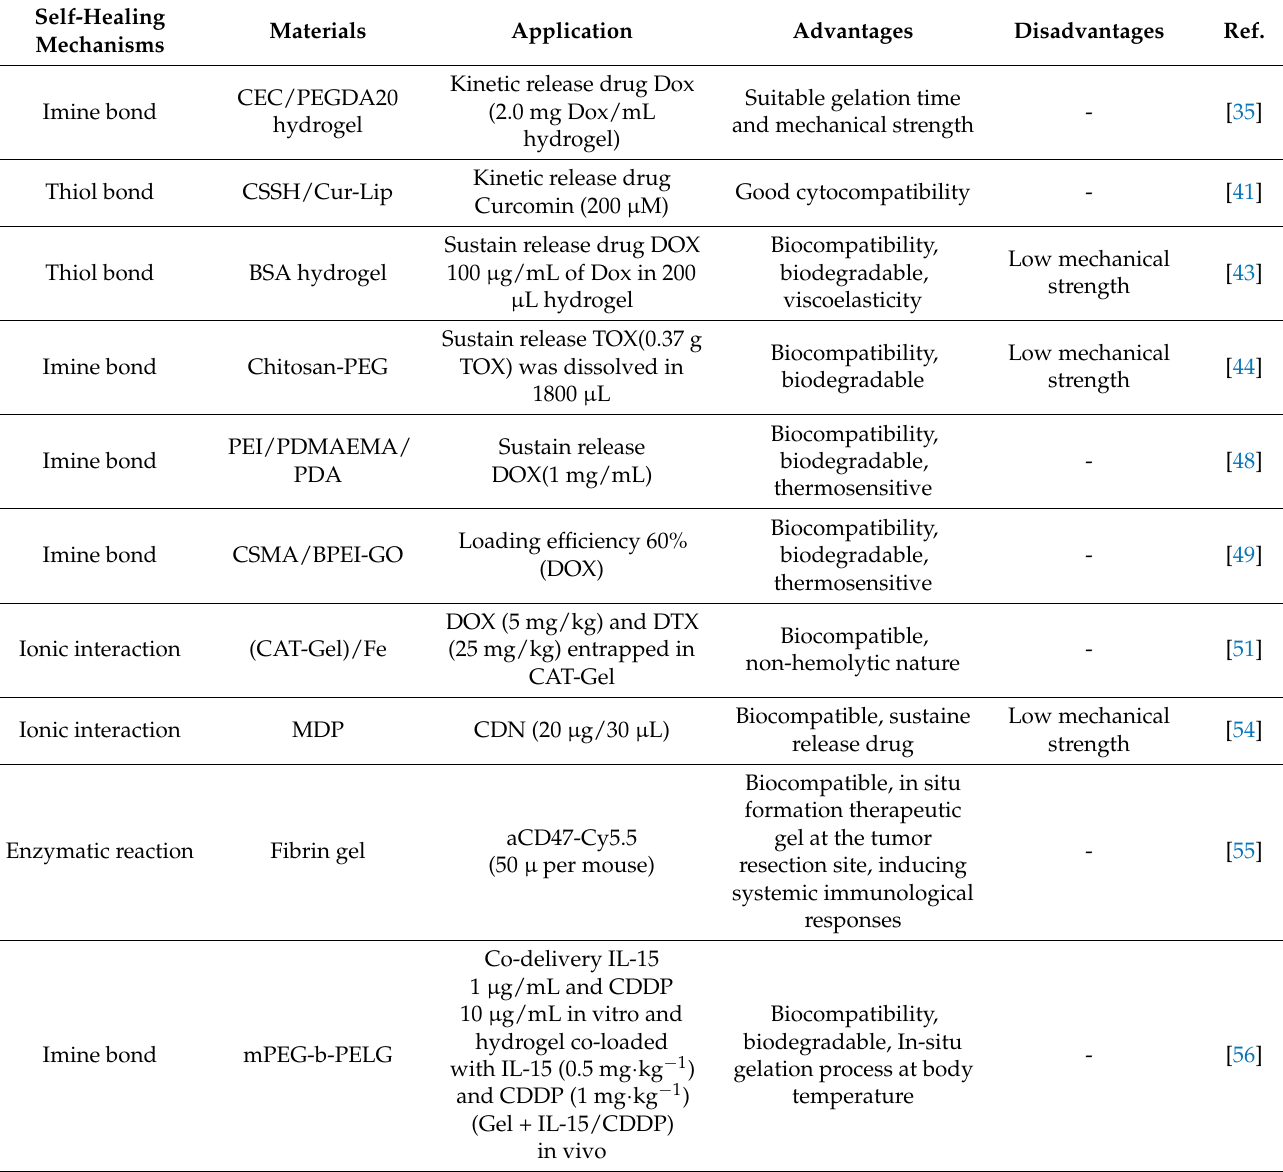
Table 2. Examples of self-healing hydrogels for cancer drug